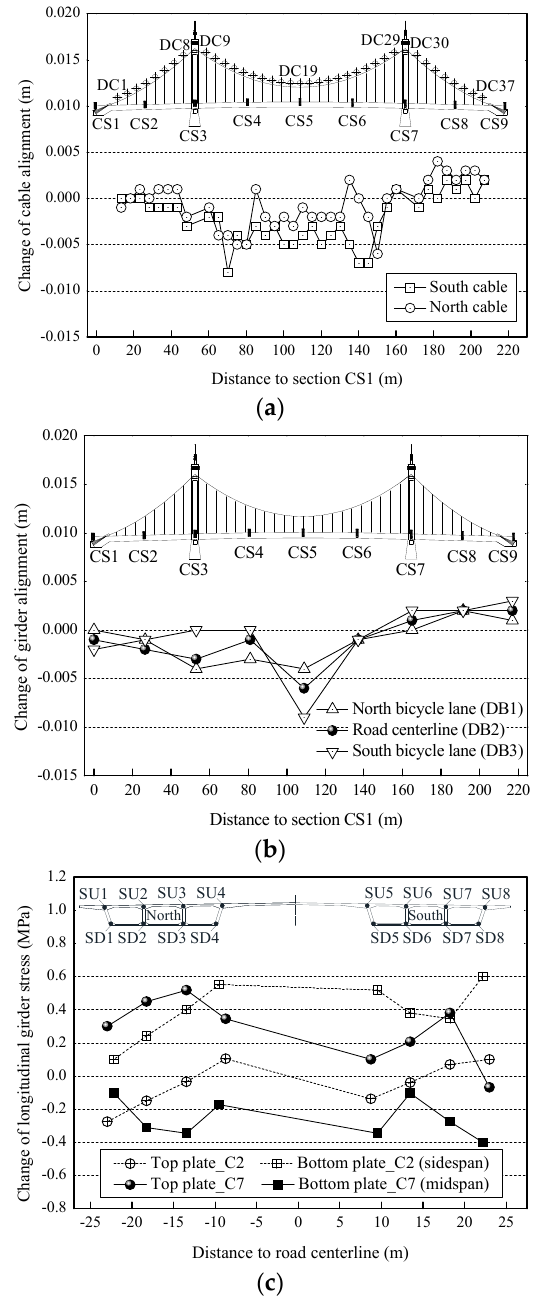
Figure 10. Measured changes of structural alignments and girder stresses caused by diurnal temperature difference from 20 °C to 35 °C: ( a ) Cable alignment; ( b ) Girder alignment; and ( c ) Girder stress.